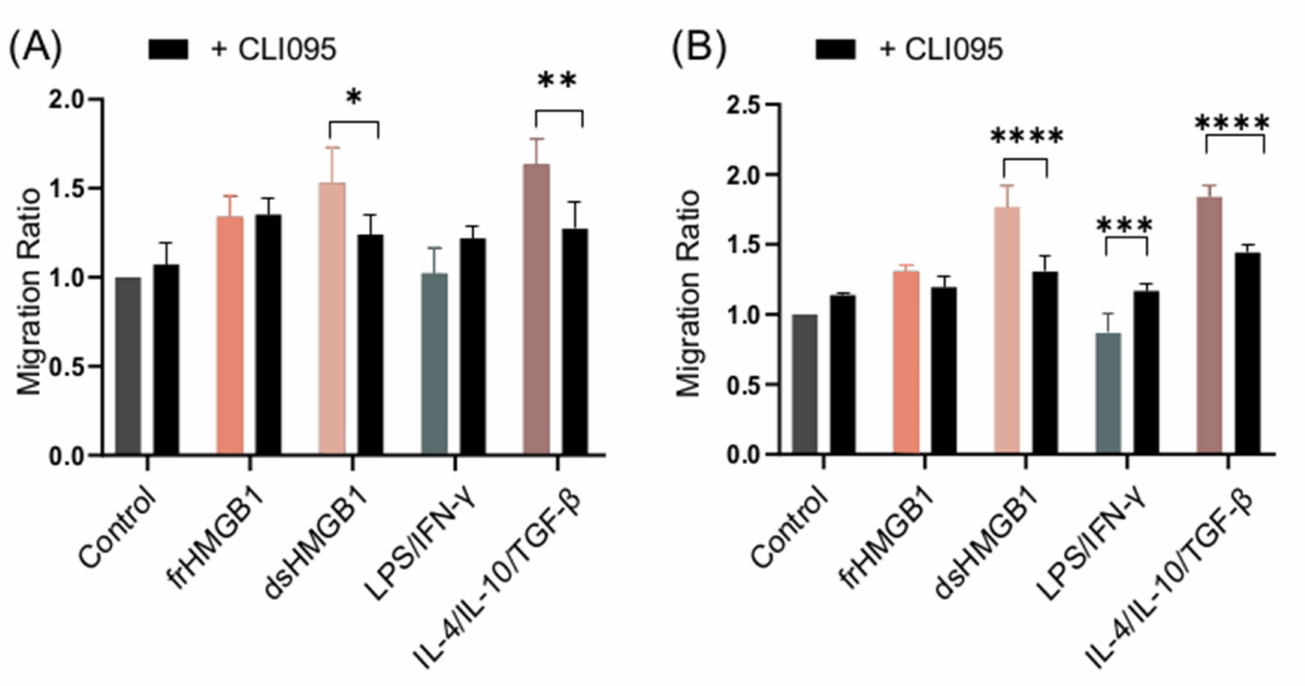
Figure 8. TLR4 inhibition reduces dsHMGB1-induced migration. Migration ratio data for ( A ) WT and ( B ) RAGE KO BMDMs treated with 1.875 µ g/mL frHMGB1 or 1.875 µ g/mL dsHMGB1 for 48 h in the presence or absence of 5 µ M CLI095, a TLR4 inhibitor. Data represent n = 4 mice (mean + SD). Statistical comparisons were performed using a two-way ANOVA and Sidak’s multiple comparisons test. * p ≤ 0.05, ** p ≤ 0.01, *** p ≤ 0.001, **** p <